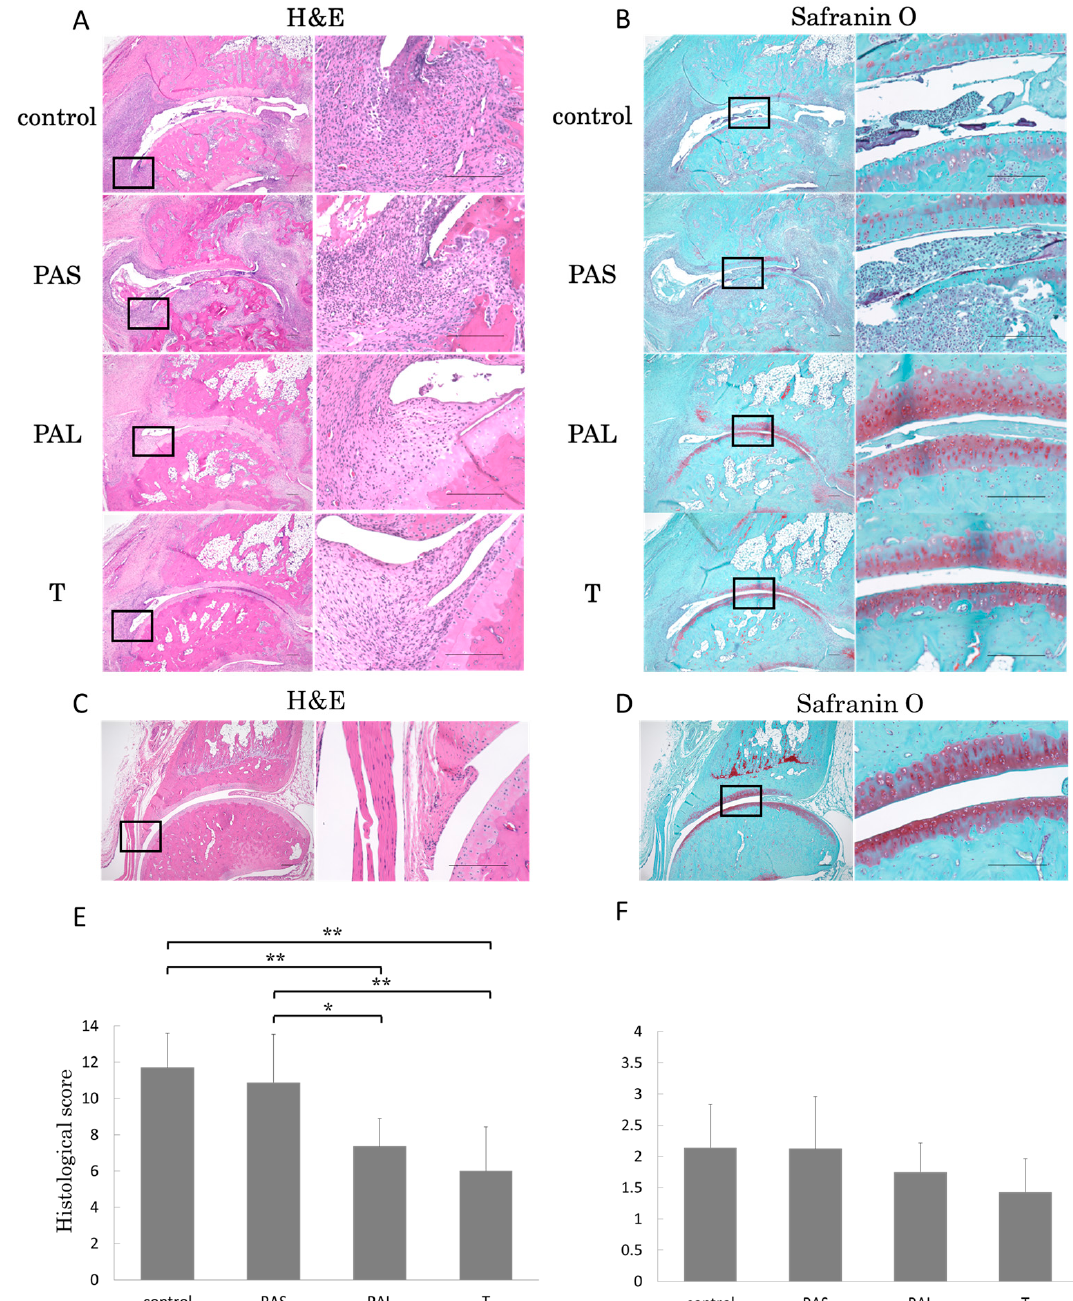
Figure 2. Representative micrographs of ( A ) hematoxylin and eosin, and ( B ) safranin O-stained sagittal sections. Representative micrographs of ( C ) hematoxylin and eosin, and ( D ) safranin O-stained sagittal sections in a normal rat without treadmill running. ( E ) The histological scores (mean ± standard deviation) and ( F ) only the cartilage evaluation scored based on the histological score (mean ± standard deviation) are shown. The PAL and T groups had suppressed destruction of the ankle joint more than the control and PAS groups. ** p < 0.01, * p < 0.05. Scale bar = 200 µ m. The black spot represents the position in the high-magnification figure.